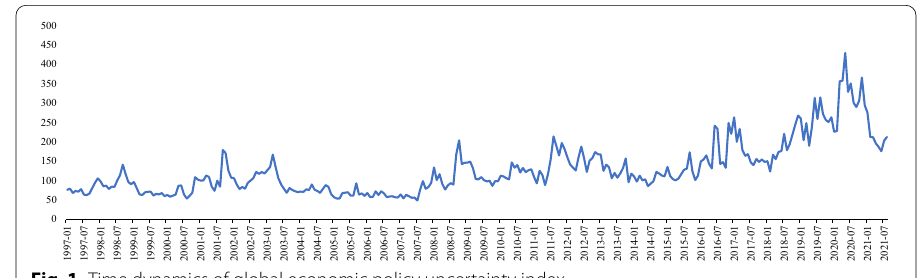
Fig. 1 Time dynamics of global economic policy uncertainty